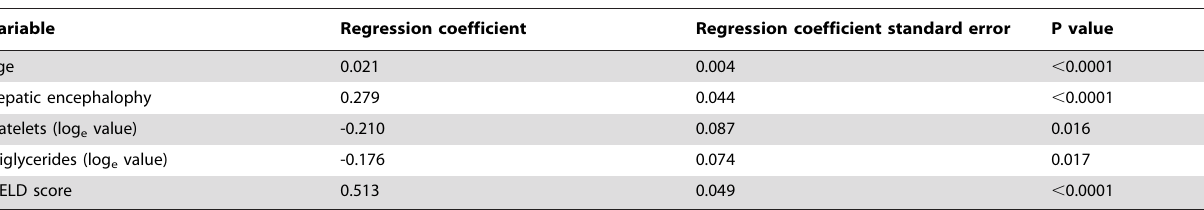
Table 4. Survival model for the training cohort*.